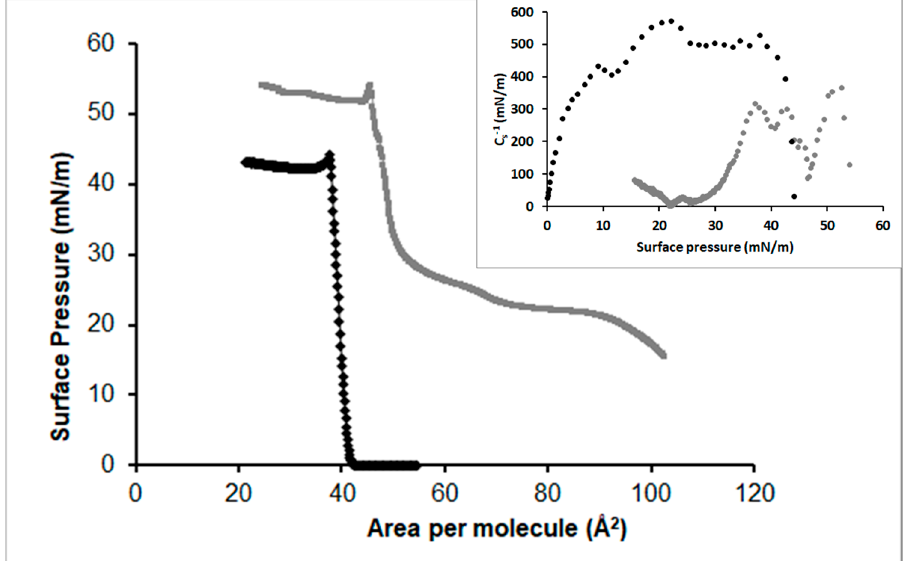
Figure 6. Surface pressure-area isotherms for CHO in the absence (black) and in the presence (grey) of lysozyme. Inset: Elastic modulus curves from the isotherms of Figure 6 for CHO in the absence (black) and in the presence (grey) of lysozyme.